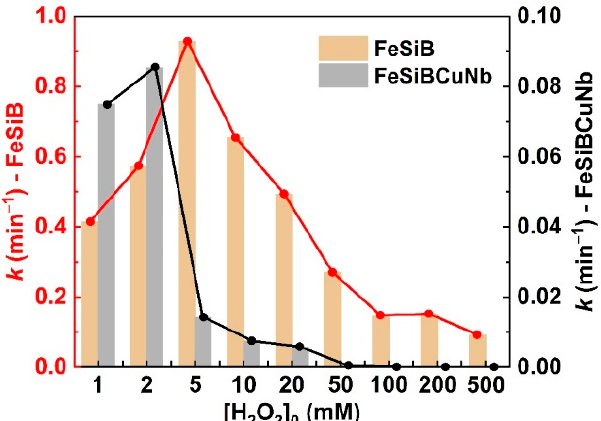
Figure 7. Reaction rate constants ( k ) of Fe 78 Si 9 B 13 (FeSiB) and Fe 73.5 Si 13.5 B 9 Cu 1 Nb 3 (FeSiBCuNb) metallic glass ribbons as a function of initial H 2 O 2 concentration ([H 2 O 2 ] 0 ) ranging from 1 mM to 500 mM (or 0.5 M) in the degradation of MO dye (dye concentration: 20 ppm, catalyst dosage: 0.5 g/L, pH 3.0, 25 °C).